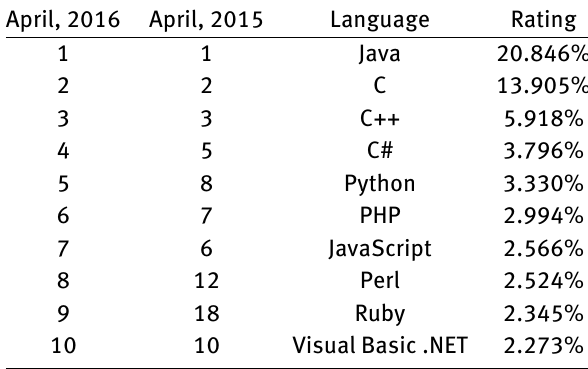
Table 1: Rating of programming languages in